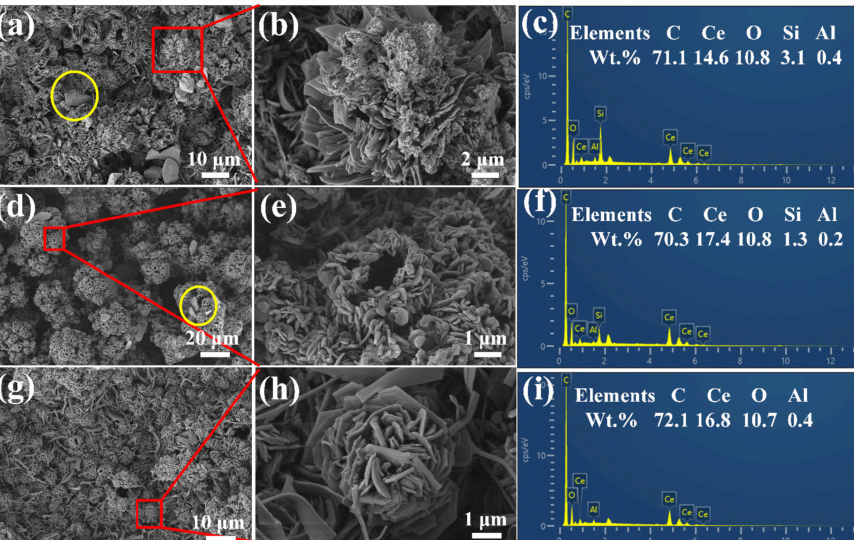
Figure 2. Surface morphologies of different electrodeposited coatings: ( a , b ) the surfaces of one-step electrodeposited surface with SiC particles (ED1); ( c ) the EDS results of the ED1 surface; ( d , e ) the surfaces of two-step electrodeposited surface with SiC particles (ED2); ( f ) the EDS results of the ED2 surface; ( g , h ) the surface of one-step electrodeposited surface without SiC particles (ED3); ( i ) the EDS results of the ED3